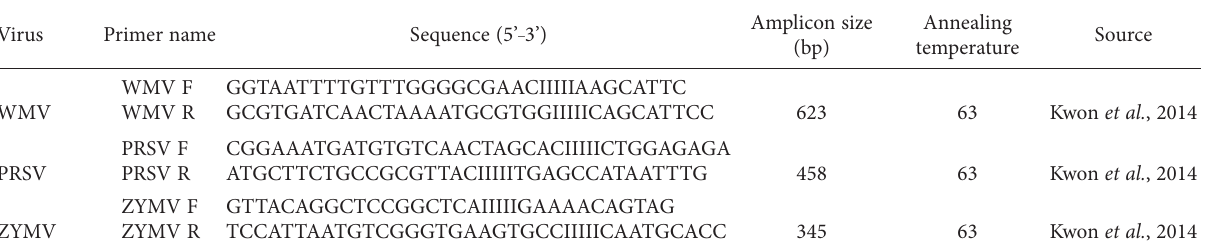
Table 4. DPO primer